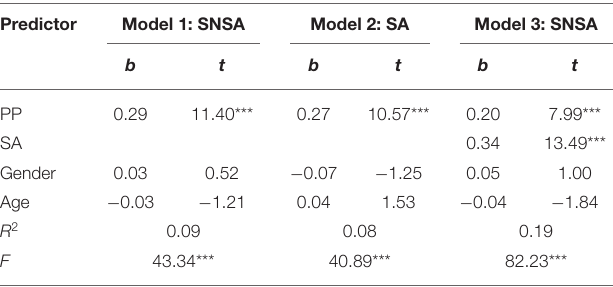
TABLE 3 | Testing the moderated mediation effect of peer phubbing on social networking site addiction. Predictor